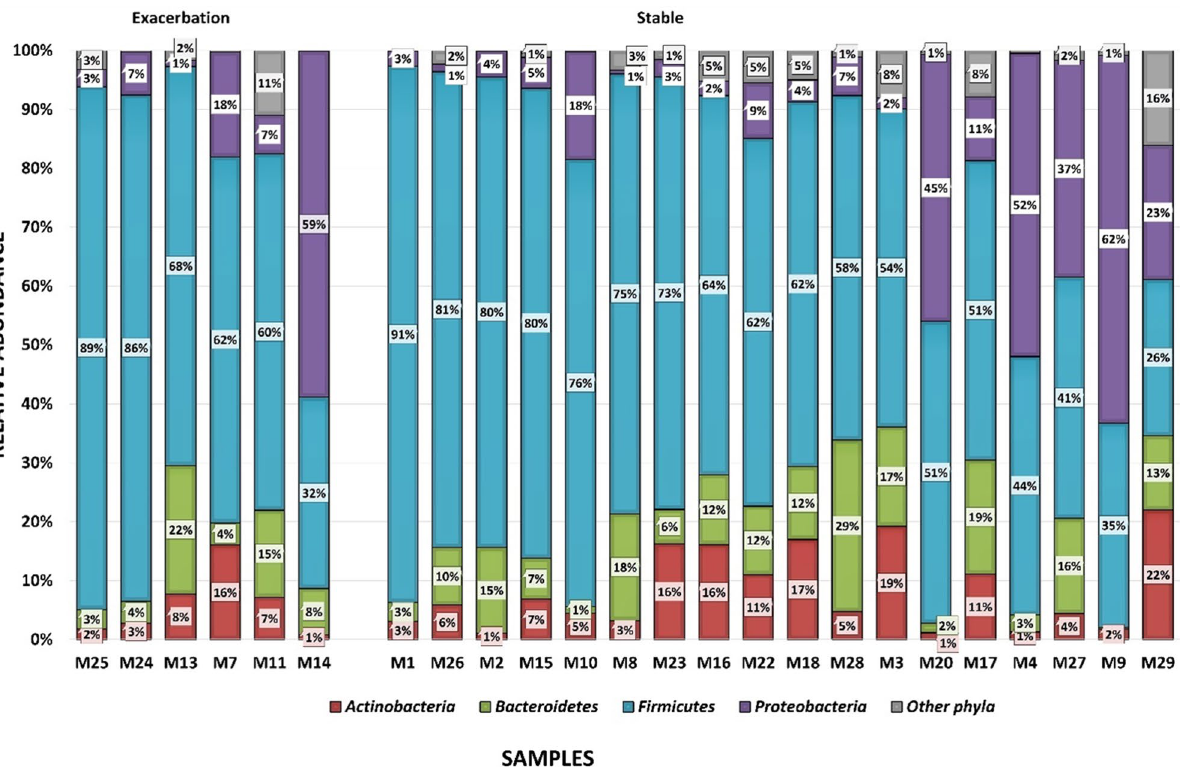
Figure 1. Bar plots showing the relative abundance of the differing phyla by disease state occurring in the sputum microbiome of 24 COPD participants using targeted metagenomics across the different samples. Firmicutes are shown in blue, Proteobacteria in purple, Bacteroidetes in green and Actinobacteria in red. The graph is separated into the exacerbated state (n = 6) and stable state (n = 18). The specimens are ordered according to the prevalence of Firmicutes